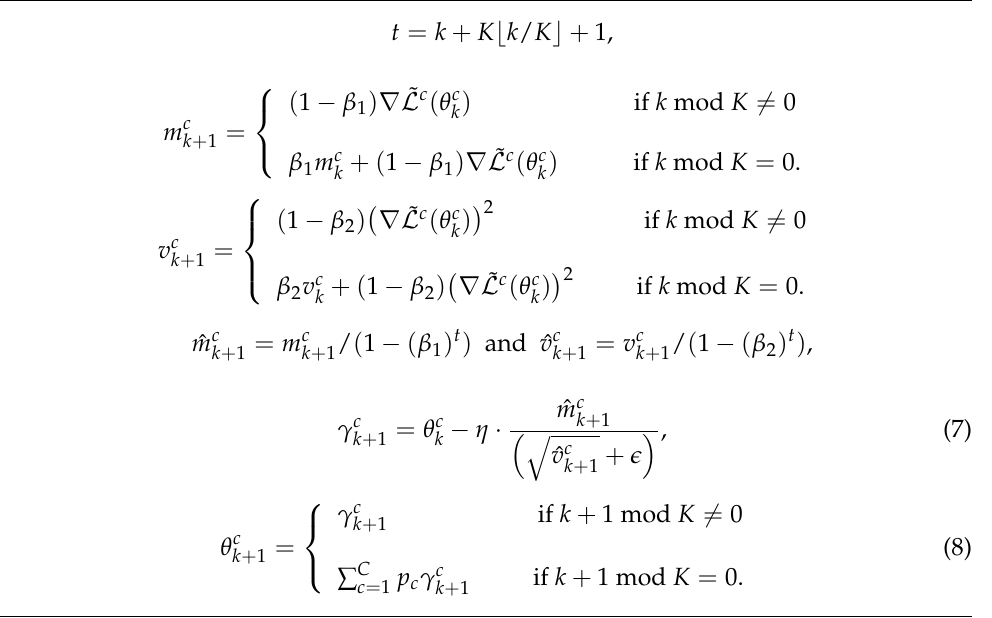
Algorithm 2 Adaptive Federated Deep Operator Network (Adaptive Fed-DeepONet) learning